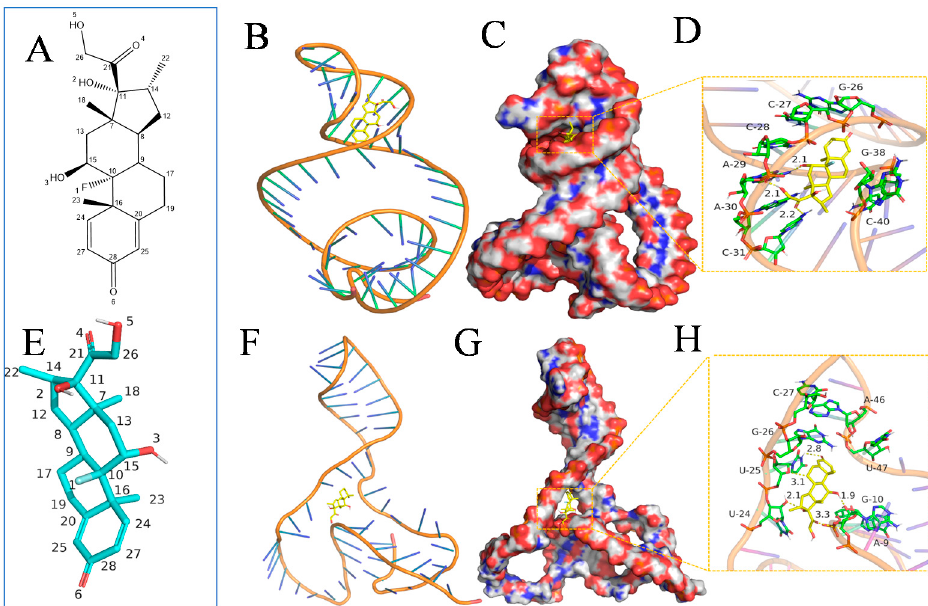
Figure 2. The atomic number of the DEX ( A , E ). The binding mode of the aptamer with DEX after MOE-Docking ( B ). The 3D structure of the complex ( C ). The electrostatic surface of the aptamer ( D ). The binding mode of the aptamer with DEX after MD ( F ). The 3D structure of the complex ( G ). The electrostatic surface of the aptamer, showing the detail binding mode of aptamer with DEX. The yellow dash represents the hydrogen bond ( H